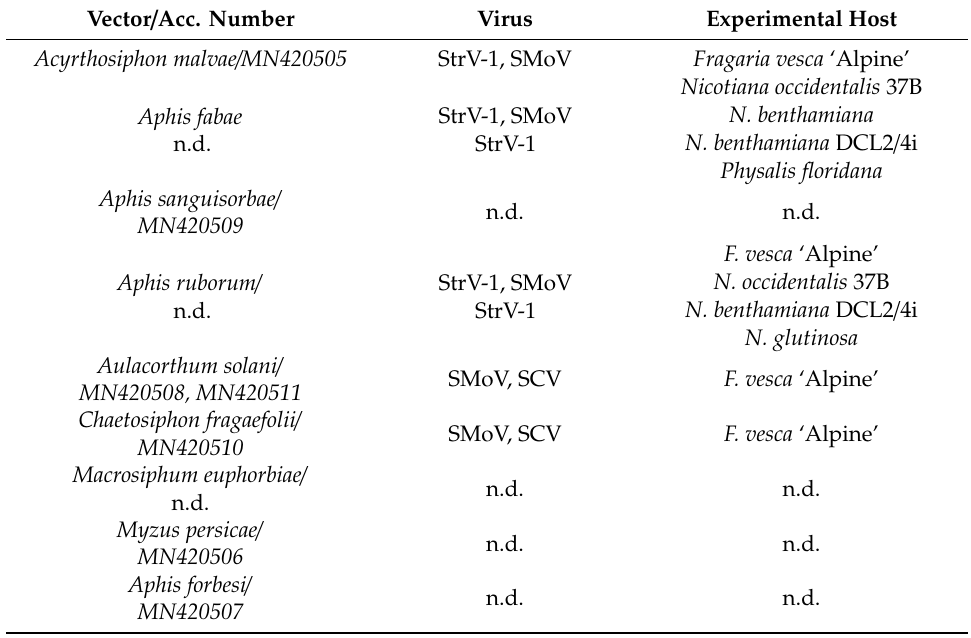
Figure 7. Aphids infesting strawberry plants in South Bohemia in 2019: ( a ) Aulacorthum solani , ( b ) Acyrthosiphon malvae , ( c , d ) Aphis sanguisorbae , ( e ) Aphis forbesi , ( f – h ) Chaetosiphon fragaefolii . To confirm the morphological identification of the aphids, PCR was conducted to amplify partial sequences of the COI and cytb genes. Nucleotide sequences were deposited in the GenBank database (Table 1). Table 1. Aphids infesting strawberry plants and experimental host plants of strawberry viruses determined in the present study. Vector / Acc. Number